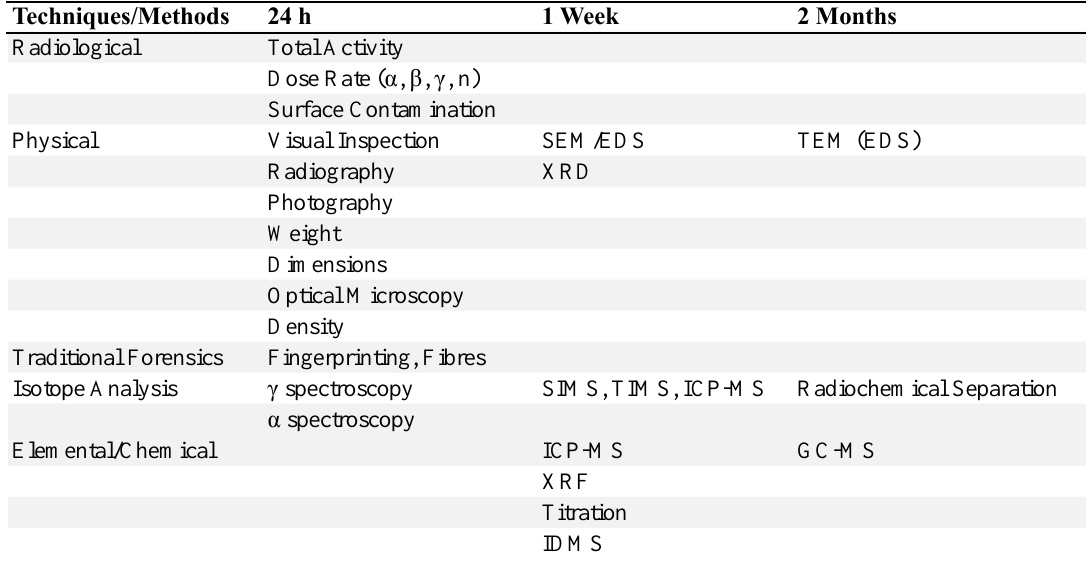
Table 1: Characterization Techniques for Pre-Detonation Nuclear Materials (IAEA) [ 15